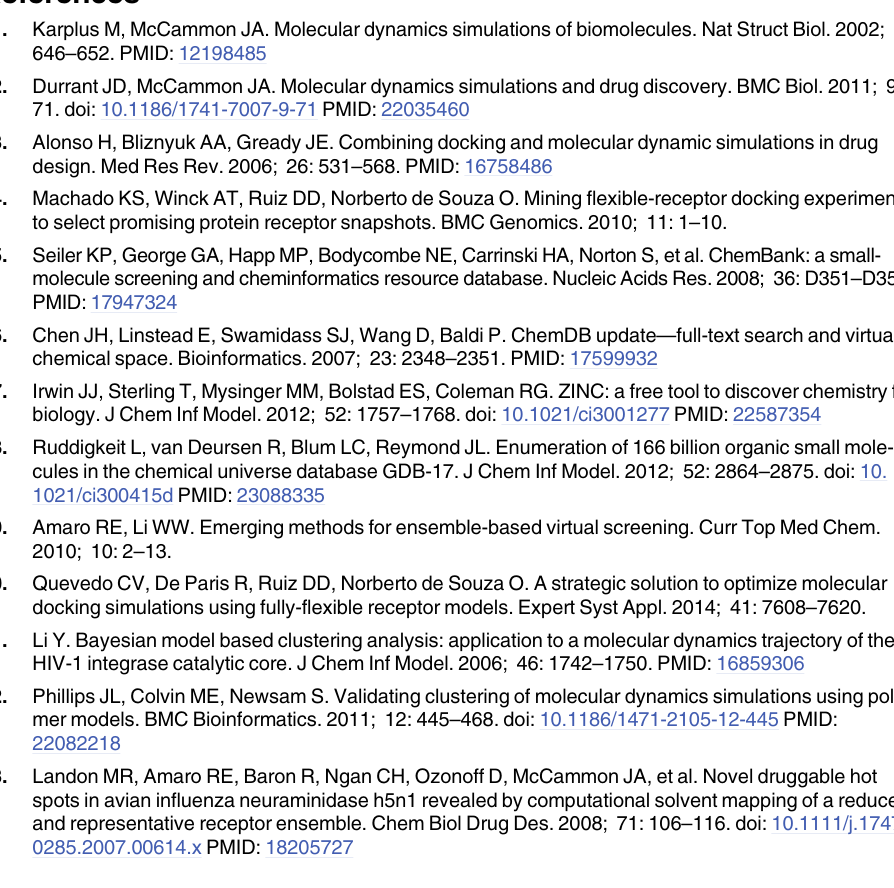
S2 Table. SQD values from Cavity RMSD data set by partitioning and clustering method used. S3 Table. SQD values from Protein RMSD data set by partitioning and clustering method